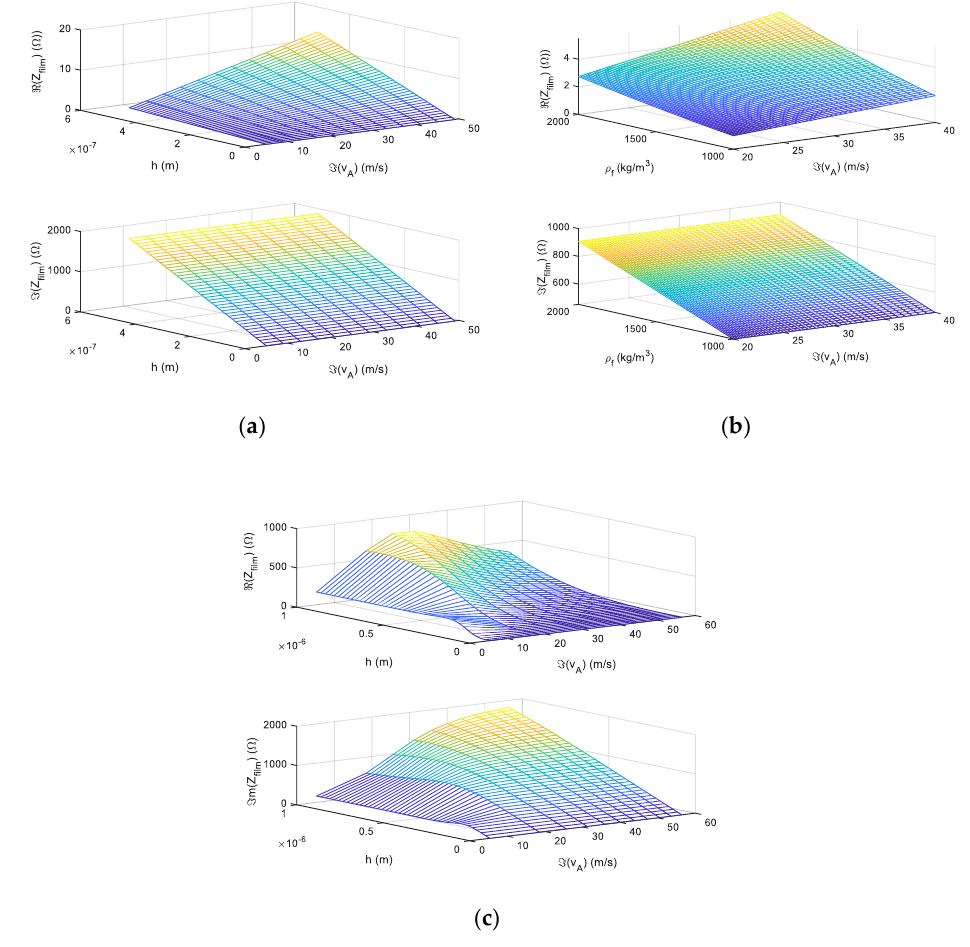
Figure 4. Real and imaginary parts of the film impedance Z film : ( a ) as a function of the thickness layer h and of the acoustic wave attenuation ( Im ( v A )), assuming a large shear modulus (the one corresponding to overlapped graphene sheets); ( b ) as a function of the acoustic wave attenuation ( Im(v A ) ) and the film density ρ f for a solid film, ( h = 200 nm), with the same large shear modulus in ( a ); ( c ) a Newtonian liquid film with the density of water.